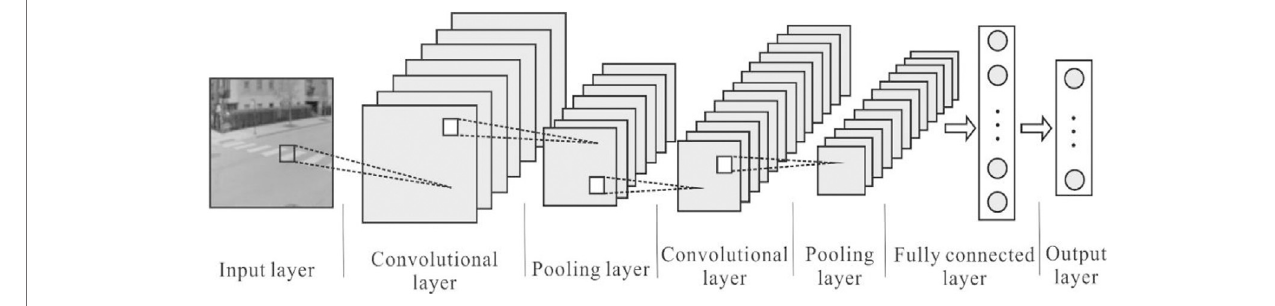
FIGURE 3 | Schematic of CNN structure.